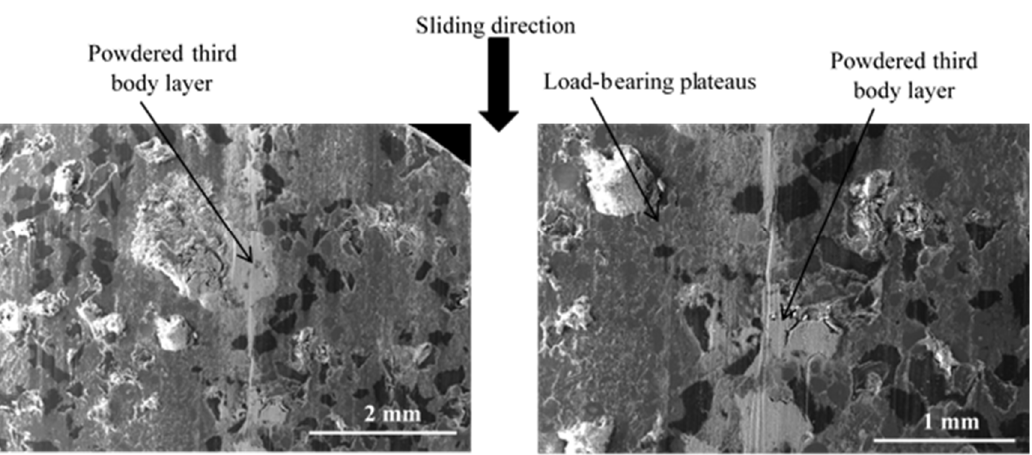
Figure 9. Open contact area at the AR for FMFS (SEM and BSE).